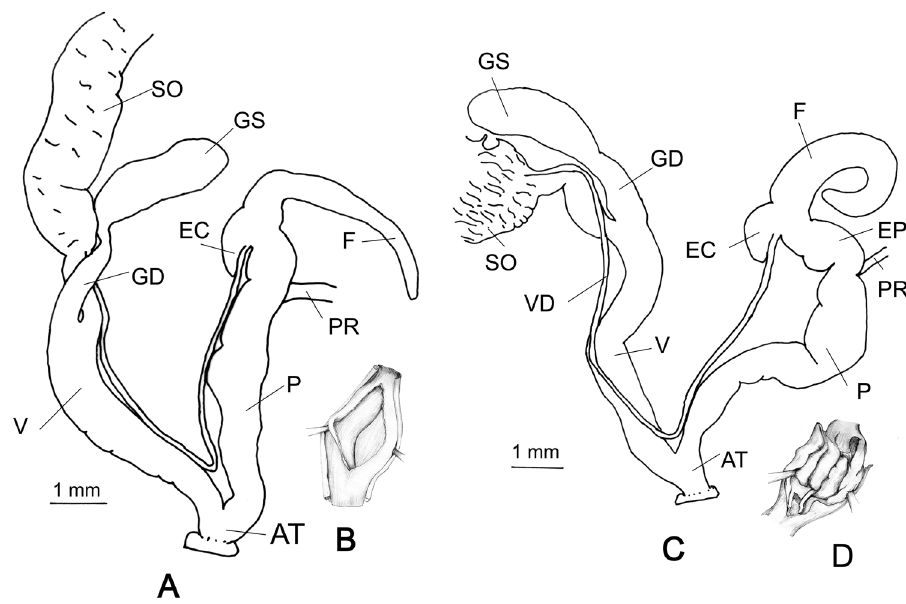
Figure 8. Genitalia of R. cf. mastersi and Rishetia sp.: A General view of R. cf. mastersi , CDZMTU065P B Interior of penis of the same, Kurintar, Chitwan, degraded riverine bushes with big boulders, mixed Shorea robusta forest C General view of Rishetia sp. CDZMTU078P D Interior of penis of the same, Boshikharka, Dhading, Central